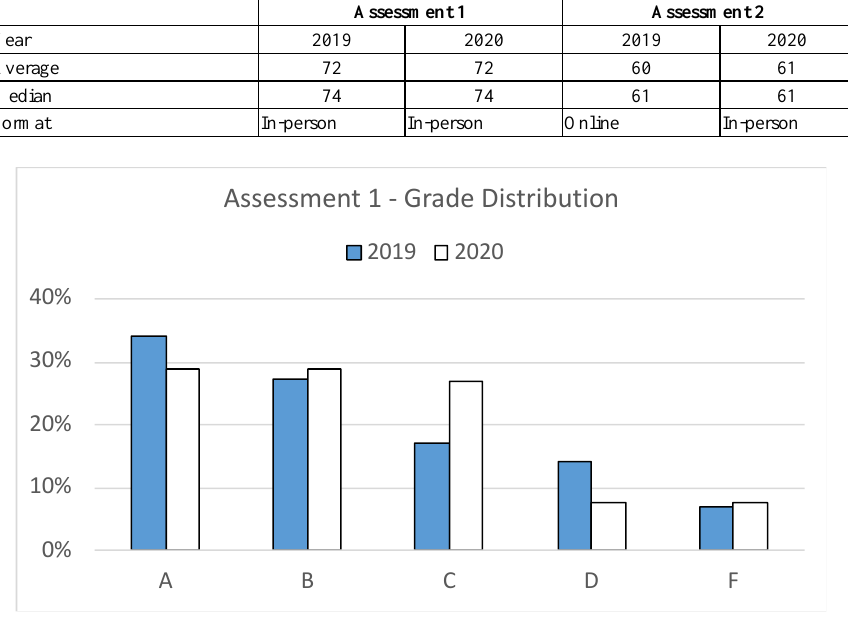
Fig. 1. Distribution of grades in Assessment-1 of